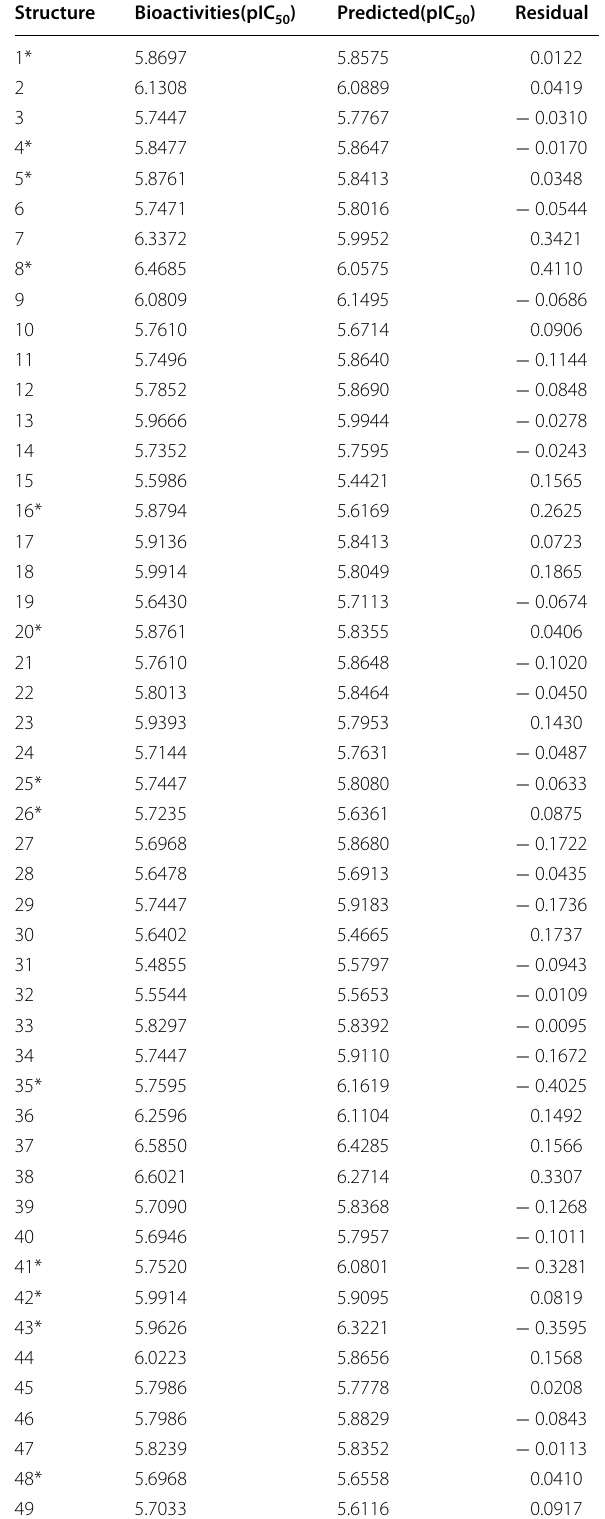
Table 9 The bioactivities (pIC the